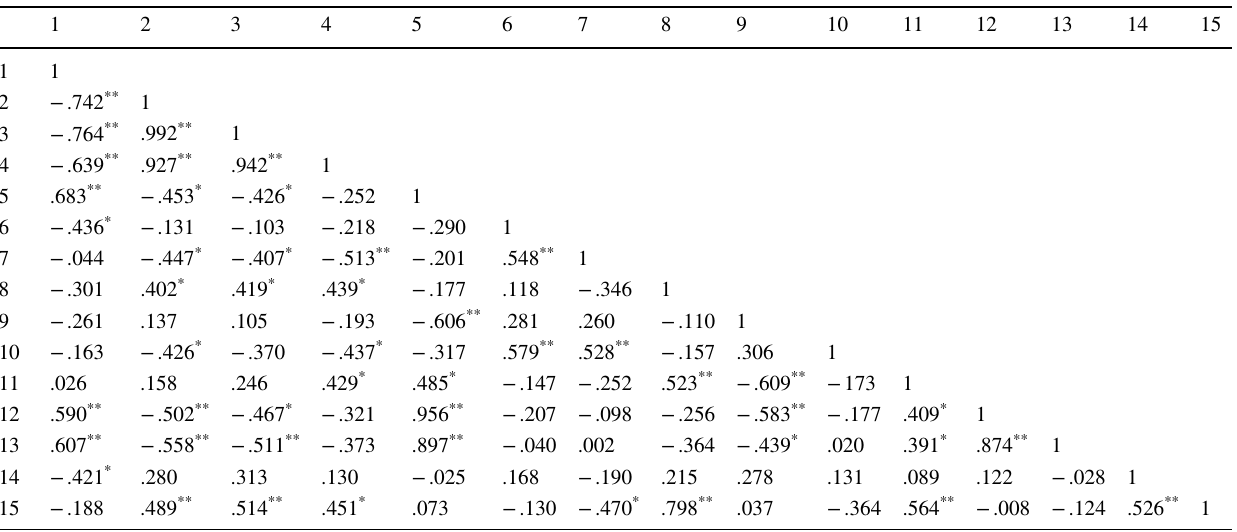
Table 3 Pearson correlation of the physicochemical properties parameters in the non-roof rainwater